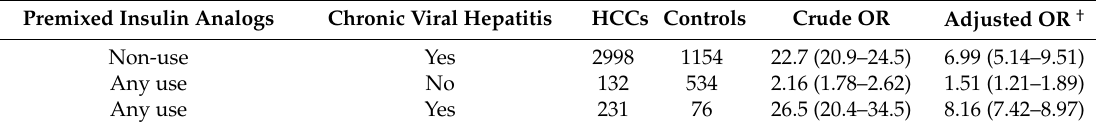
Interaction between premixed insulin analogues and chronic viral hepatitis on risk of hepatocellular carcinoma among newly diagnosed type 2 diabetes patients prescribed antidiabetic